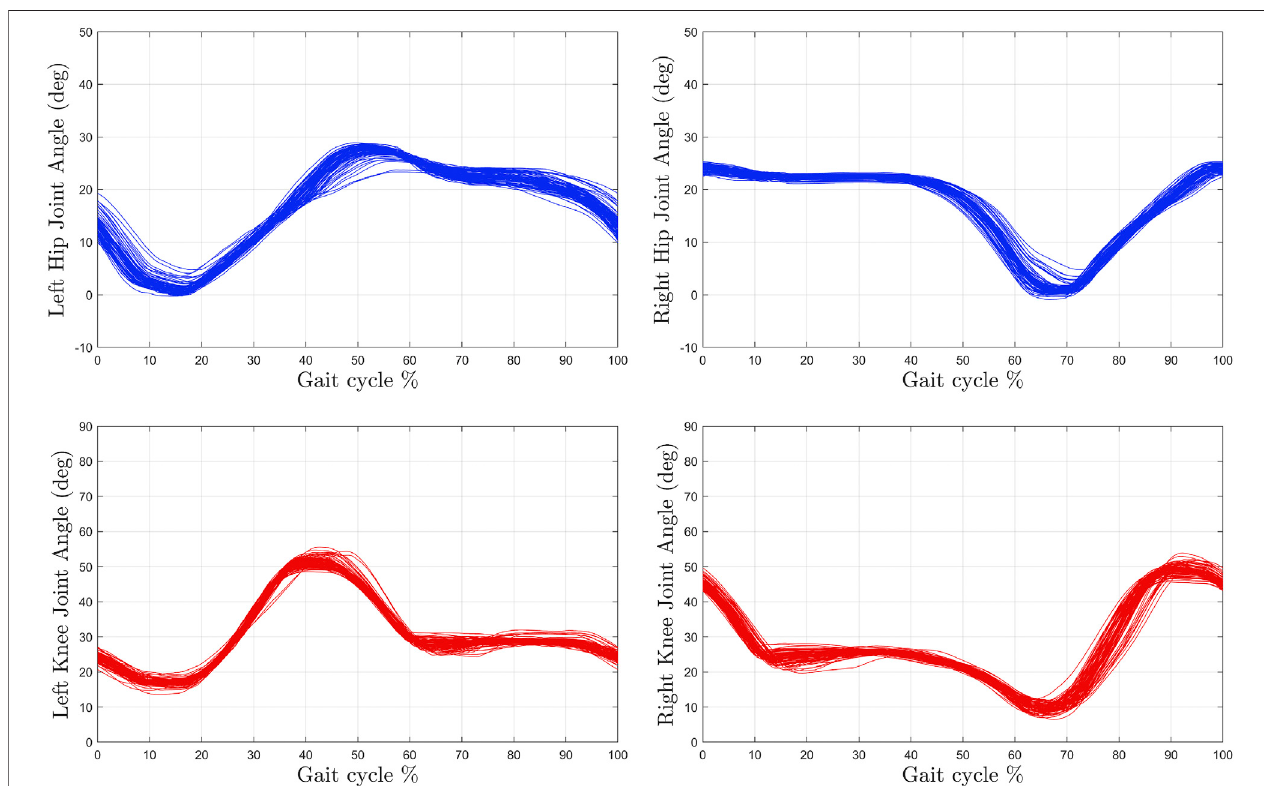
FIGURE 8 | The kinematic joint trajectories corresponding to each gait cycle during the treadmill walking experiment at high speed (0.8 mph) for Subject 1 (S1).